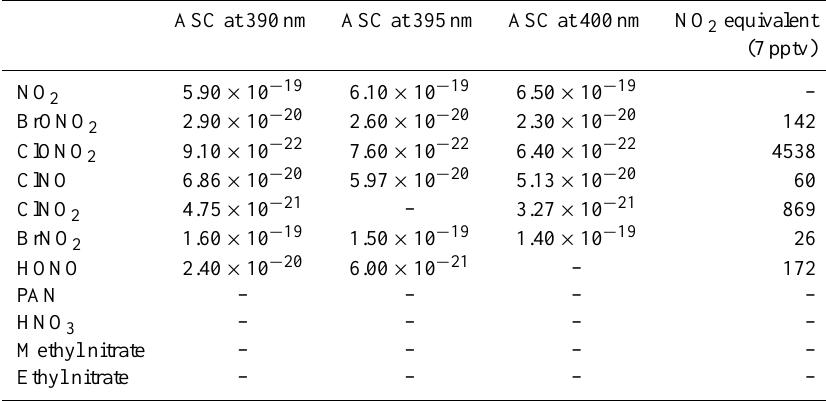
Table 5. Absorption cross section of potentially interfering